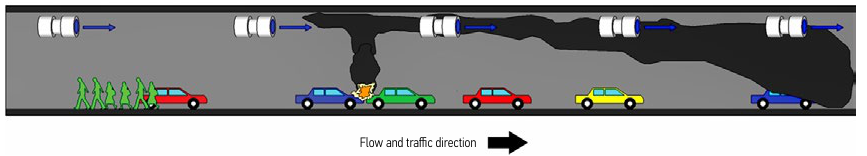
Fig. 4. Operation of jet fans